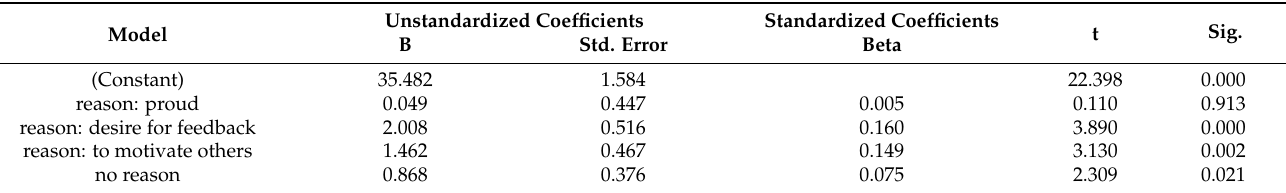
Table 4. Multiple regression to test the influence of egoistic motives for sharing health-related self-tracked data on the probability to